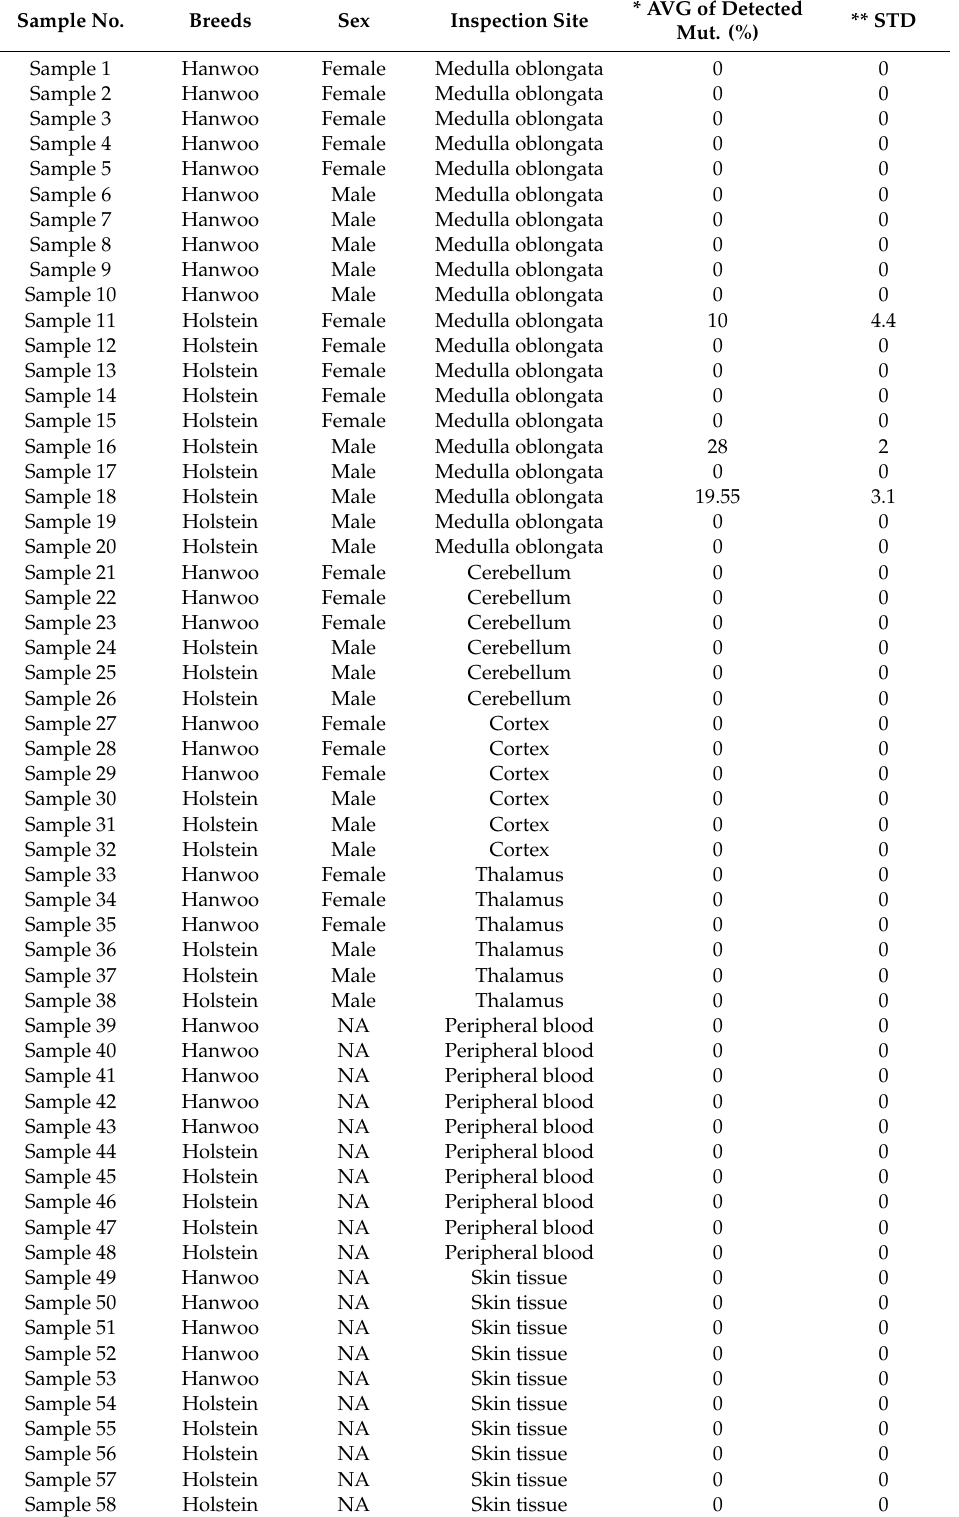
Table 3. K211 somatic mutation rates of the prion protein gene ( PRNP ) observed in Hanwoo and Holstein